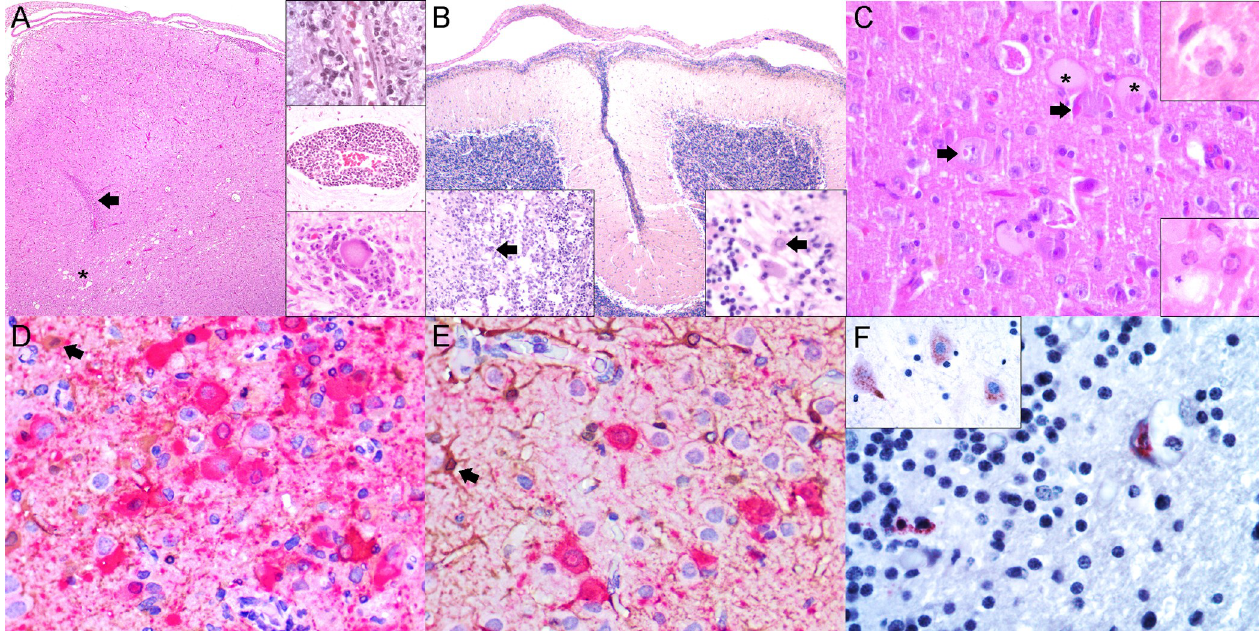
Fig 2. Cetacean-morbillivirus (CeMV)-associated lesions in central nervous system of striped dolphins ( Stenella coeruleoalba ), bottlenose dolphins ( Tursiops truncatus ), and Guiana dolphins ( Sotalia guianensis ). (A) Cerebral meningoencephalitis (case 14). The leptomeninges are inflamed and there is increased cellularity in the underlying cortex and subcortical white matter. A large perivascular cuff (arrow) and a few spongy foci (asterisk) are noted. 20x. H&E. Right upper inset: small lymphocytic and plasmacytic perivascular cuff in the cerebral cortex (case 14). 400x. H&E. Right middle inset: thick perivascular cuff at the gray/white matter interface (case 18). 200x. H&E. Right lower inset: degenerating neuron cell body with microglial neuronophagic nodule (case 19). 400x. H&E. (B) Cerebellar meningoencephalitis (case 13). Diffusely, the pia mater, arachnoid, and dura matter are infiltrated by mononuclear inflammatory cells. 40x. H&E. Left inset: mononuclear inflammation at molecular, Purkinje cell, and inner granular cell layer interface with edema, rarefaction, and focal multinucleate giant cell/syncytial cell (MGCS; arrow) (case 19). 200x. H&E. Right inset: Less severely inflamed cerebellar interface area with three degenerating Purkinje cells, one of which displays a viral intranuclear inclusion body (arrow) (case 19). 400x. H&E. (C) Cerebral cortex (case 26). Degenerating swollen neurons and necrotic neurons with intranuclear and intracytoplasmic viral inclusion bodies. 400x. H&E. Right upper inset: Degenerating swollen astrocyte with intracytoplasmic inclusions. 400x. H&E. Right lower inset: Degenerating neuron with intranuclear inclusion body and adjacent necrotic neuron. 400x. H&E. (D) Cerebral cortex (case 26). Marked positive labeling for CeMV-antigen (red) in degenerating neurons and fewer astrocytes (GFAP-brown) (arrow). There is loss of astrocytic processes and cell bodies in this focus. 400x. Double IHC for CeMV and GFAP. (E) Cerebral cortex (case 26). Moderate labeling for CeMV-antigen in neurons and less so in astrocytes (arrow). There is relative preservation of astrocytes in this focus compared to figure (D) but those present have plump nuclei, cytoplasm, and processes. Note astrocytic processes reaching the perivascular space show occasional positivity for CeMV as well. 400x. Double IHC for CeMV and GFAP. (F) Cerebellum (case 1). There is positive labeling for CeMV-antigen in endothelium focally and adjacent neuroglia. 400x. IHC for CeMV. Inset: CeMV positive labeling in neuronal soma and axon hillock of frontal cerebral cortex (case 9). 400x. IHC for CeMV.